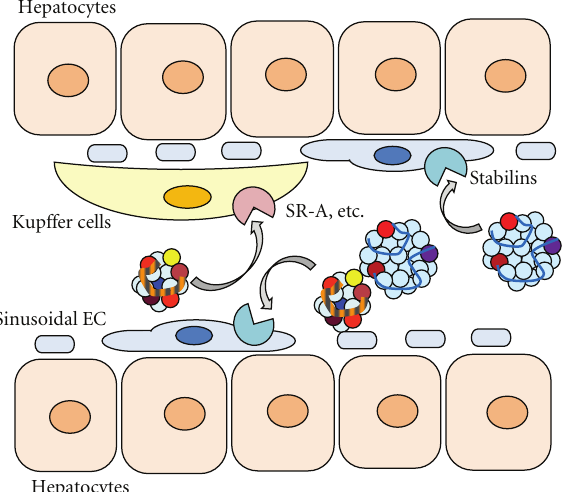
Figure 4: Stabilins, novel endothelial scavenger receptors, could have a role in the clearance of OxLDL in the liver and from circu- lation. Heavily oxidized LDL is taken up by Kup ff er cells, whereas sinusoidal endothelial cells can take up both mildly and highly oxidized form of LDL. The novel scavenger receptors stabilin-1 and -2, which can bind to both types of OxLDL, could be involved in the process of clearing OxLDL from the circulation in the